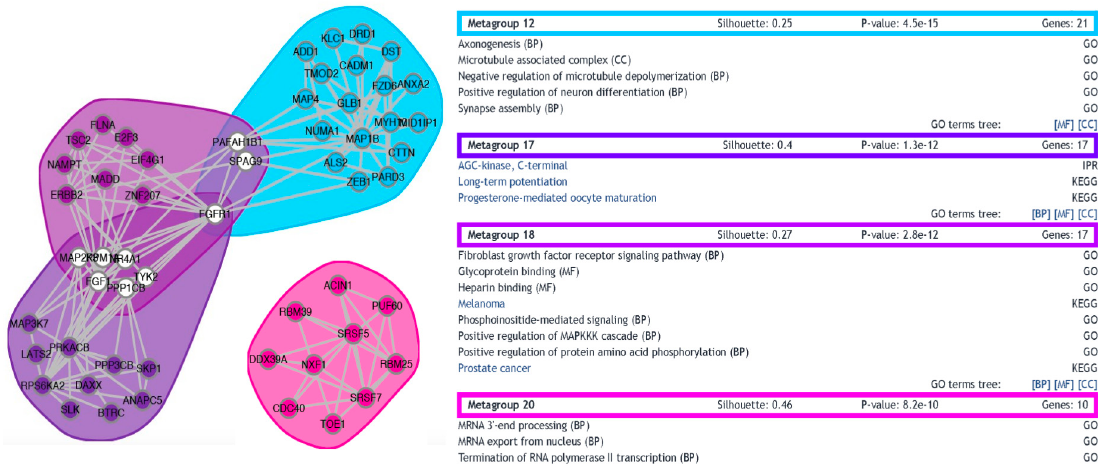
Figure 4. Functional network of differentially expressed transcripts. A functional network was built with functional gene networks (FGNet) (version 3.6) [37] based on the set of differentially expressed transcripts. The figure shows a filtered version of the full network, in which only metagroups of silhouette size greater than 0.2 are represented. On the left, the four surviving metagroups are graphically described, clustered by functional relationship in color-delimited areas. Genes are represented by circles and the connections between them by lines. White circles depict genes that were assigned to multiple metagroups. The number of genes, silhouette size, and p -value are also shown for all groups, as well as the functional categories they include (BP: Biological processes; MF: Molecular functions; CC: Cellular components).